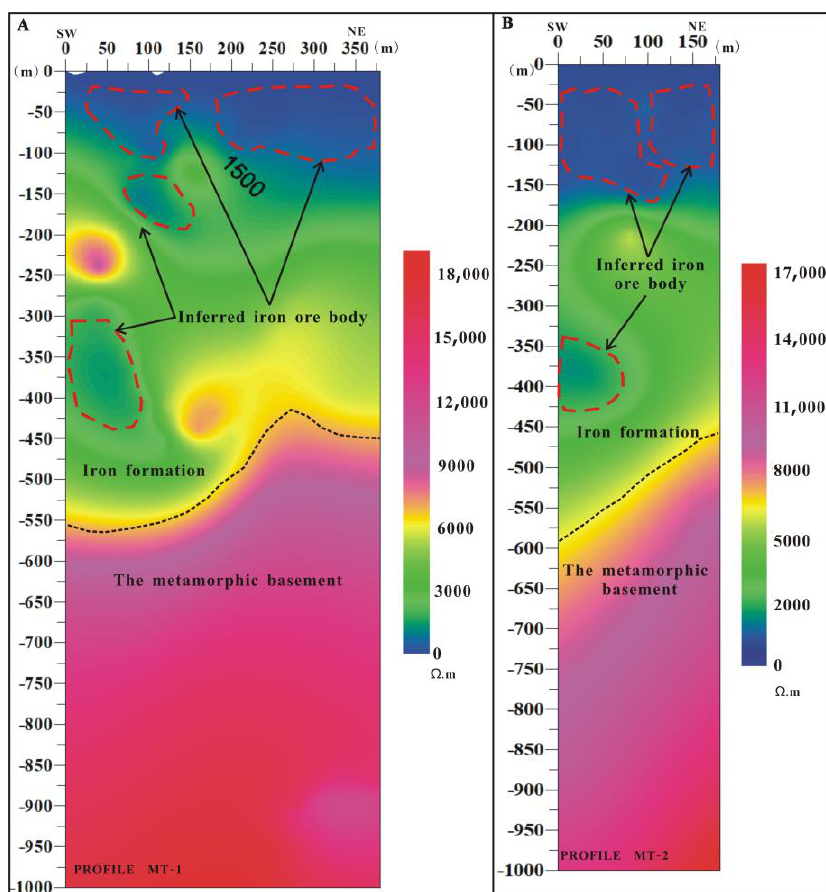
Figure 8. Magnetotelluric method (MT) data inversion results from the EH4 survey. ( A ) The resistivity section of the MT profile MT‐1; ( B ) The resistivity section of the MT profile MT‐2.